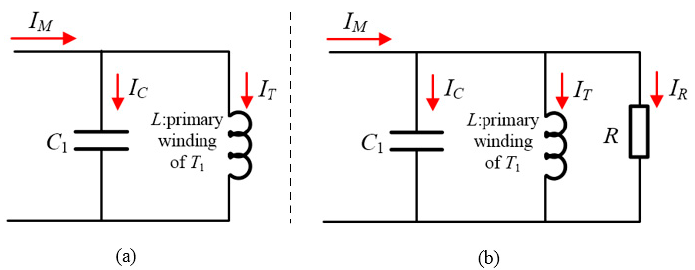
Figure5. Theequivalentpowerconversioncircuit: ( a )Underno-loadcondition; ( b Figure 5. The equivalent power conversion circuit: ( a ) Under no-load condition; ( b ) under loading condition.